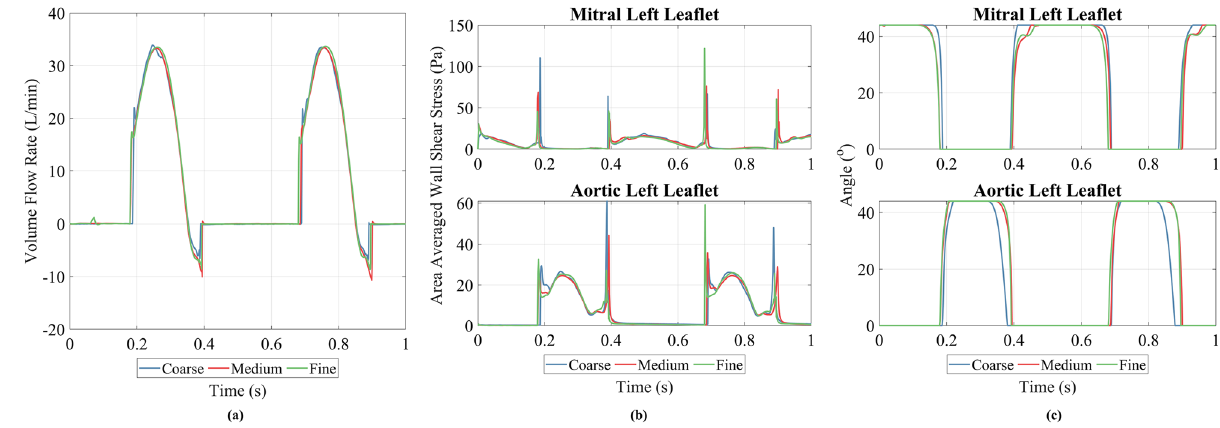
Figure 2. Mesh study results for the coarse, medium and fine meshes, showing ( a ) transient outlet volume flow rate, ( b ) transient leaflet angle for the left mitral and left aortic valve leaflet and ( c ) area-averaged transient wall shear stress for the left mitral and left aortic valve